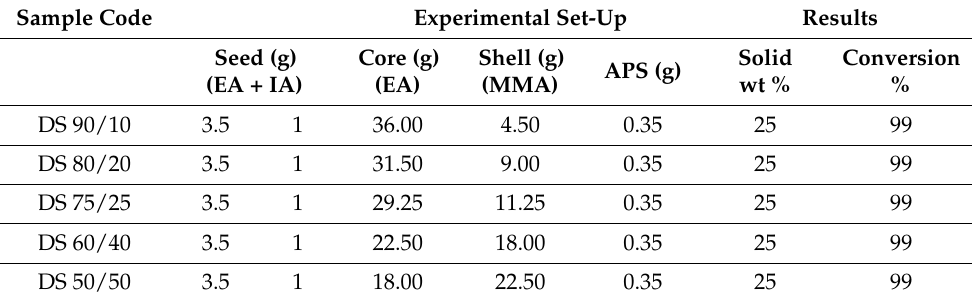
Table 1. Experimental set-up and reaction parameters for copolymer emulsion.